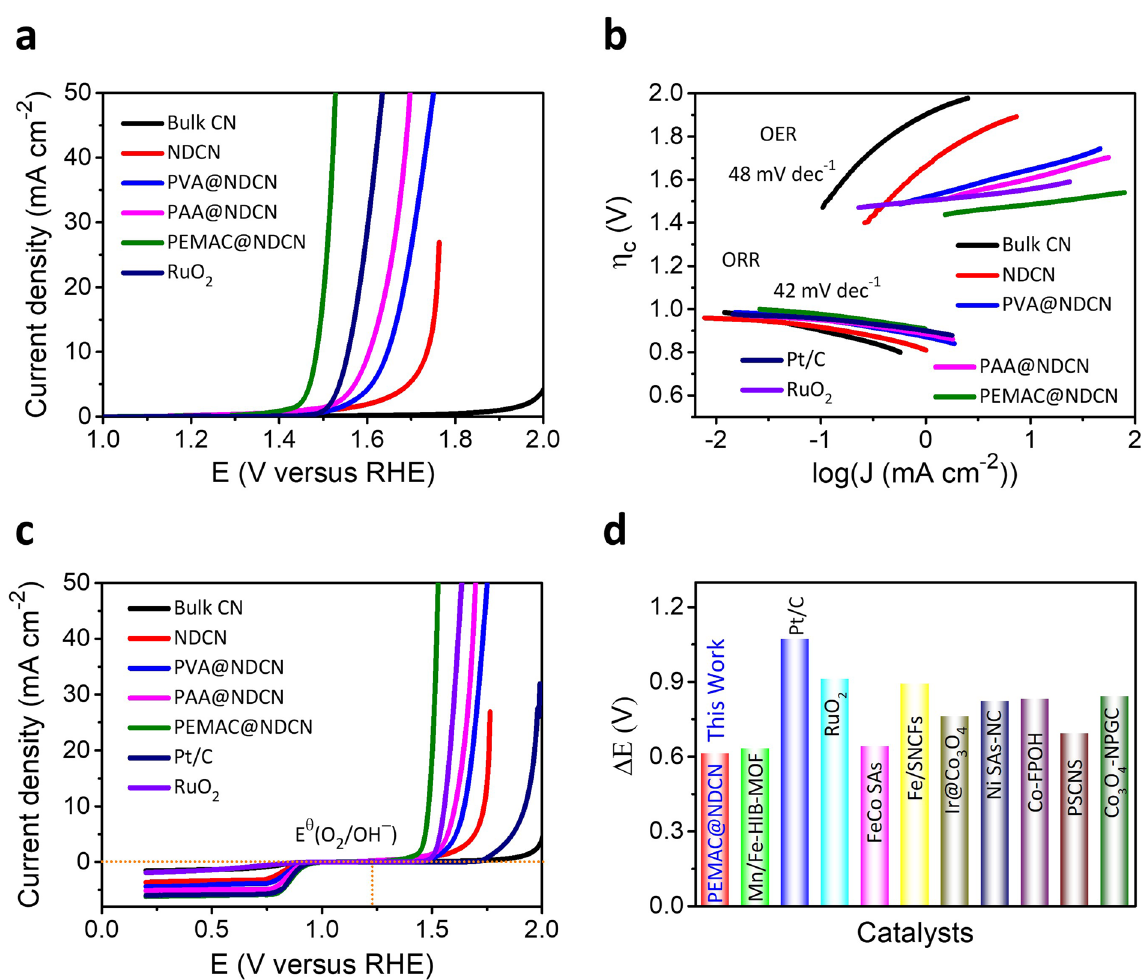
Fig. 6 Electrochemical OER performances for visualization as bifunctional metal‑free catalysts. a LSV profiles for the PEMAC@NDCN com‑ pared to those of commercial RuO 2 , and prepared PVA@NDCN, PAA@NDCN, NDCN, bulk CN catalysts. b Tafel plots for electrochemical kinetics during ORR and OER for PEMAC@NDCN, PVA@NDCN, PAA@NDCN, NDCN, and bulk CN compared those of commercial refer‑ ence Pt/C and RuO 2 materials. c Overall bifunctional polarizations of designed polymeric catalysts compared to those of commercial reference Pt/C and RuO 2 materials. d Comparison of oxygen bifunctional reversibility (Δ E ) of PEMAC@NDCN with reported champion materials (for details see Supplementary Table S4). (Conditions: 0.1 M KOH, RHE scale, RDE: 1600 rpm, current standardized with a geometrical surface area of